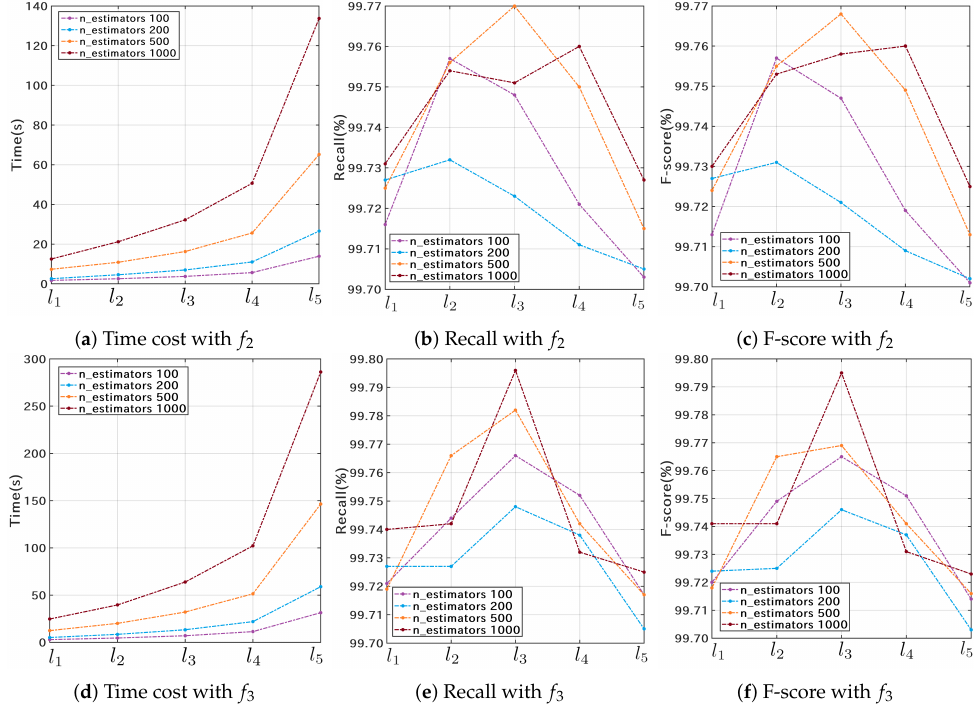
Figure 7. Cross-validation results of the RF classifier on the Nextstrain training dataset S N and second rows represent the validation results using the f 2 and f 3 data structures,